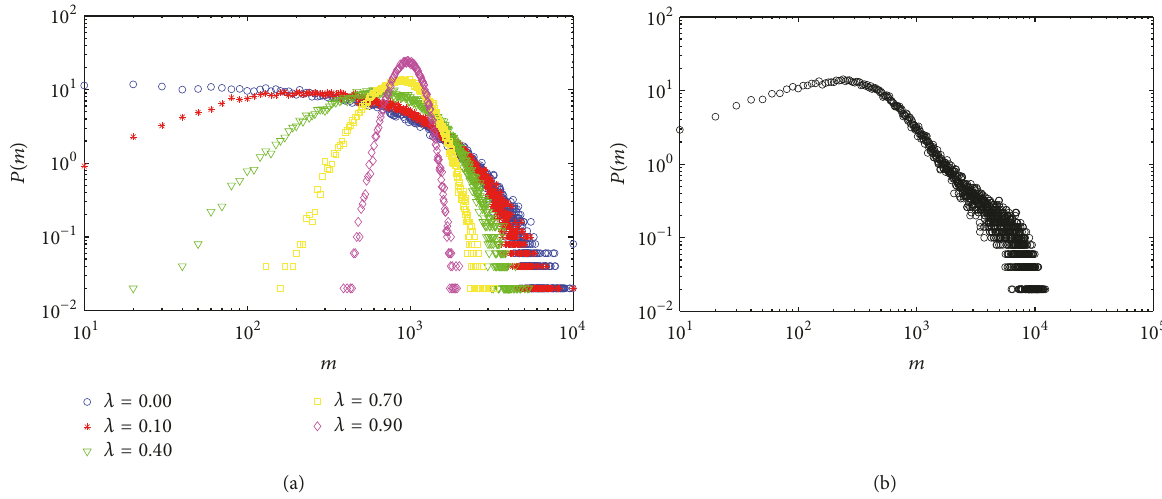
Figure 2: Results obtained by reproducing the distributions of money obtained in [29, 31]. In panel (a), the money distributions are shown for cases where saving is a homogeneous feature in the system. The blue circles show the boundary case with 𝜆 = 0.00 , which corresponds to an exponential distribution as reported in [32]. The cases with 𝜆 = [0.10, 0.40, 0.70, 0.90] are shown with circles of red, green, yellow, and magenta, respectively. These results correspond to a gamma distribution as reported in [31]. In panel (b), the money distribution for 𝜆 distributed heterogeneously in the system is shown, which corresponds to a Pareto distribution as reported in [29].